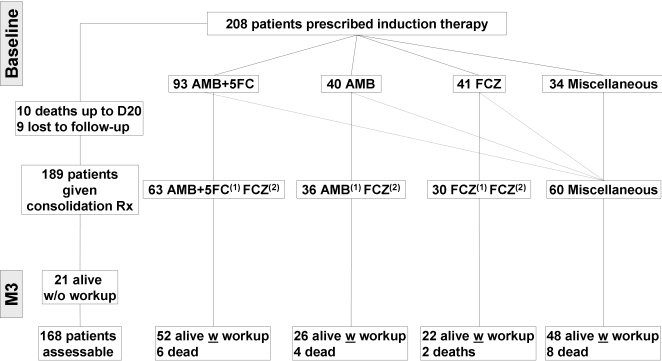
Flow chart showing the actual number of patients with cryptococcosis included in the description and analysis of the consolidation phase and outcome 3 months (Mo3) after onset of antifungal therapy.Of the 208 patients enrolled initially, 10 died during the induction phase and 9 were lost to follow-up leaving 189 patients for the description of disease and outcome. At the Mo3 workup, 168 patients were assessable including 148 patients alive with mycological assessment and 20 who had died. The remaining 21 patients alive were not included in the final analysis since they had no mycological evaluation at the Mo3 workup.